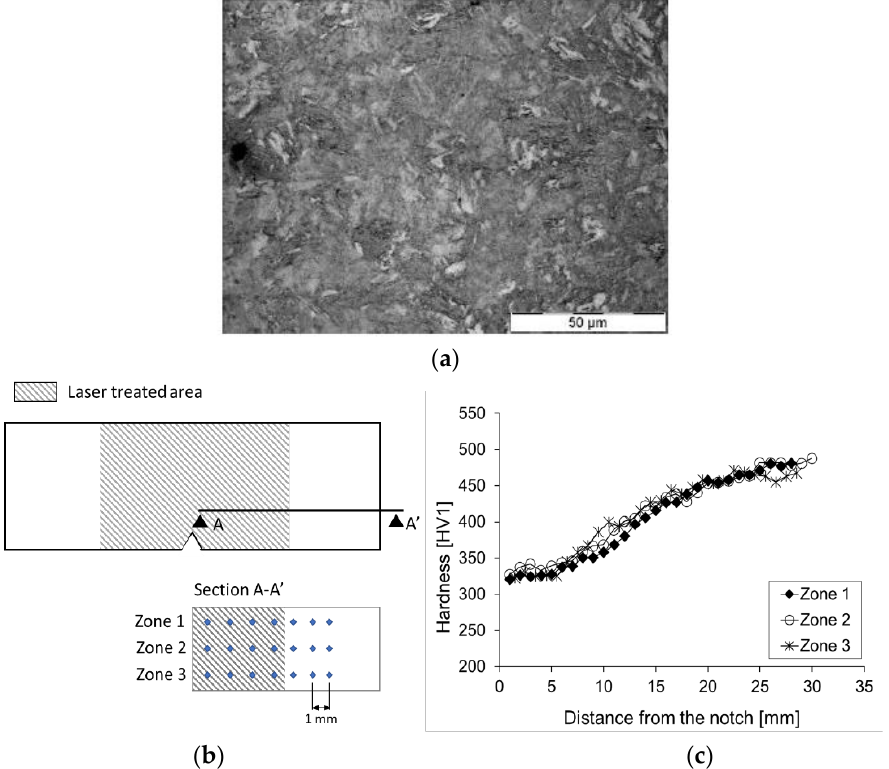
Figure 6. Laser tempering of thick sheet: ( a ) Tempered Martensite microstructure; ( b ) schematic representation of the indentations performed for hardness measurements in laser treated specimens and ( c ) Vickers hardness (HV1)